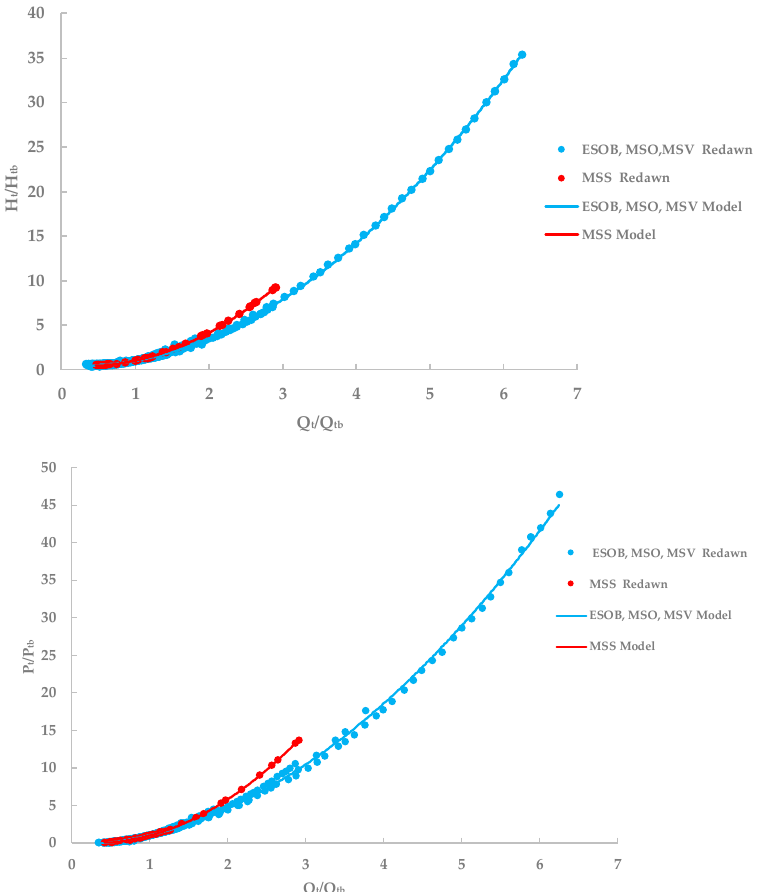
Figure 5. Redawn database: head-discharge ( upper panel) and power-discharge ( lower panel) dimensionless characteristic curves.